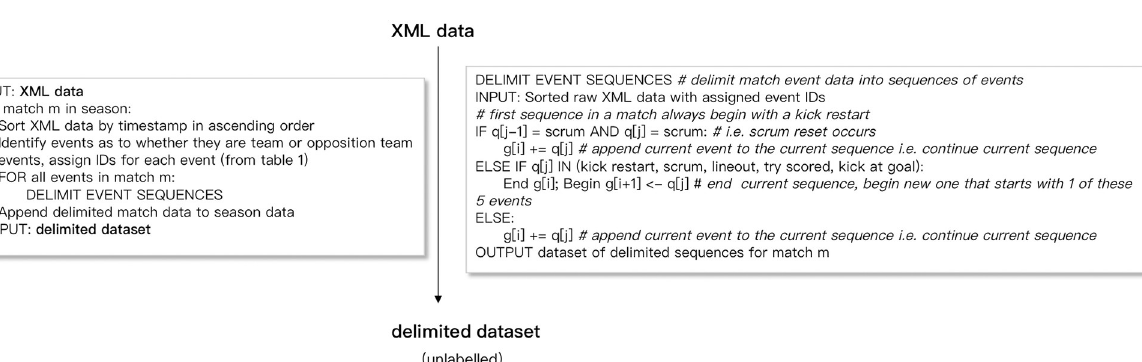
PLOS ONE | https://doi.org/10.1371/journal.pone.0256329 September 23, 2021 8 /